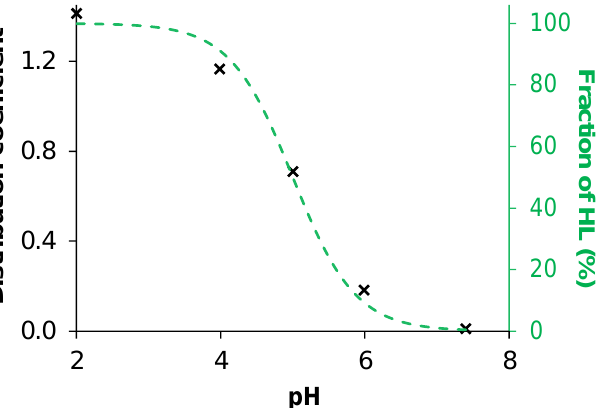
Figure 3. Distribution coefficient ( D ) of FAVI determined in n -octanol/aqueous systems at various pH values plotted together with the calculated molar fraction of the neutral HL form [ionic strength ( I ) = 0.1 M (KCl); t = 25 °C].